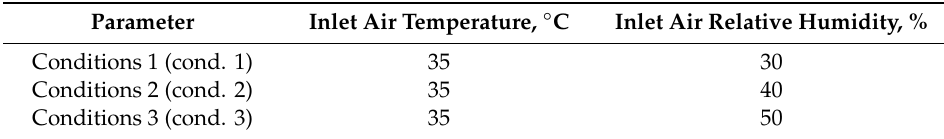
Table 7. Nominal inlet air conditions for the simulation.